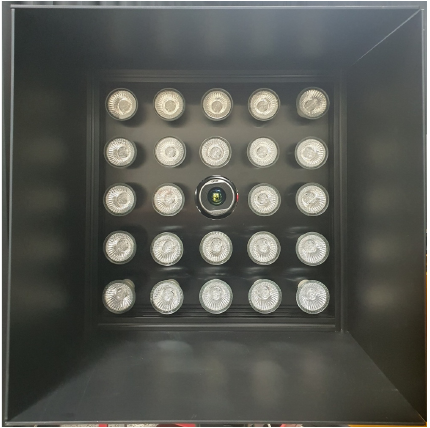
Figure 5. Halogen lamp device of 5 × 5 array type. Infrared camera placed in the center.